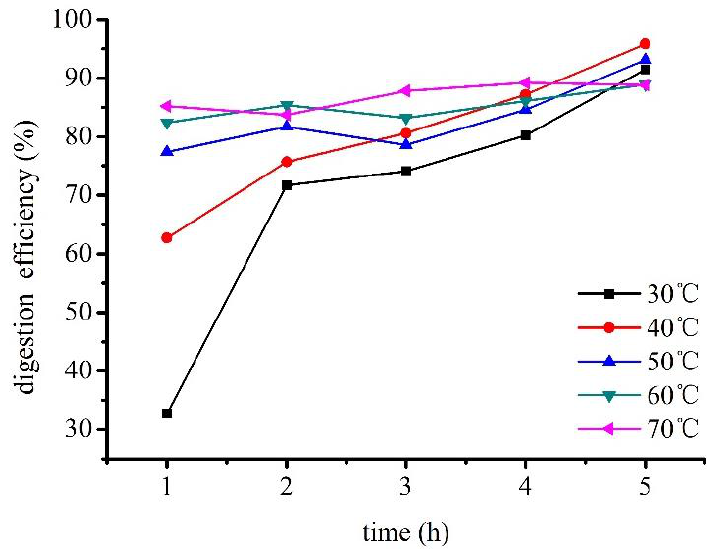
Figure 2. Digestion efficiency of mussels at different digestion temperatures and times.